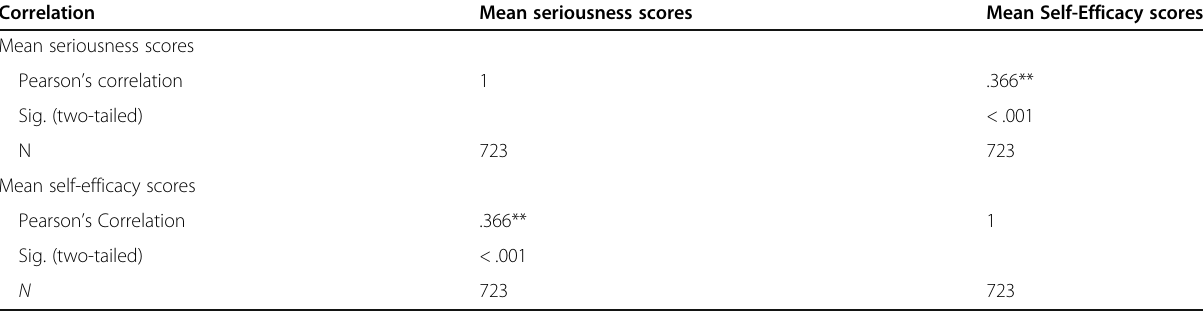
Table 11 Correlation between the perception of COVID-19 seriousness and self-efficacy mean scores Correlation